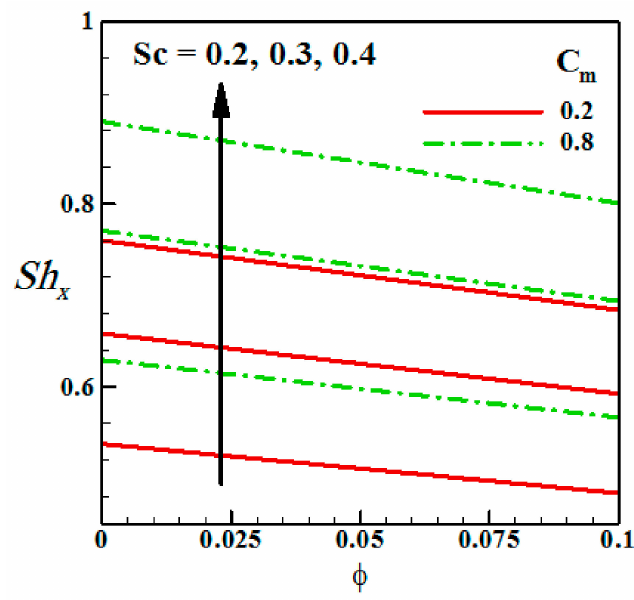
Figure 5. Variation of local Sherwood number with φ for different values of Sc and C m